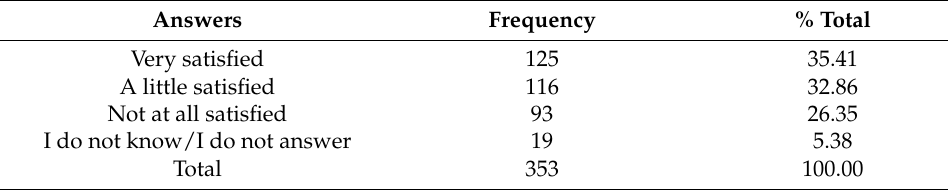
Table 5. Results for the attitude of the Church during the health crisis.